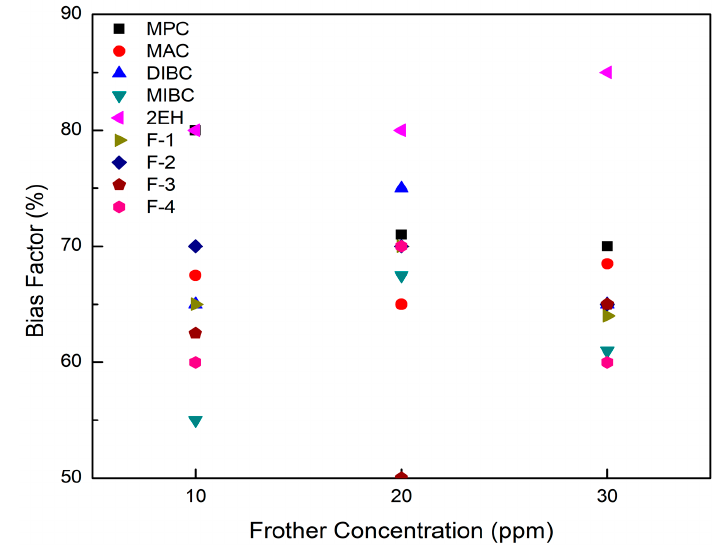
Figure 5. Bias factor values measured over a range of frother concentrations at a fixed aeration rate for each of the nine frother types.